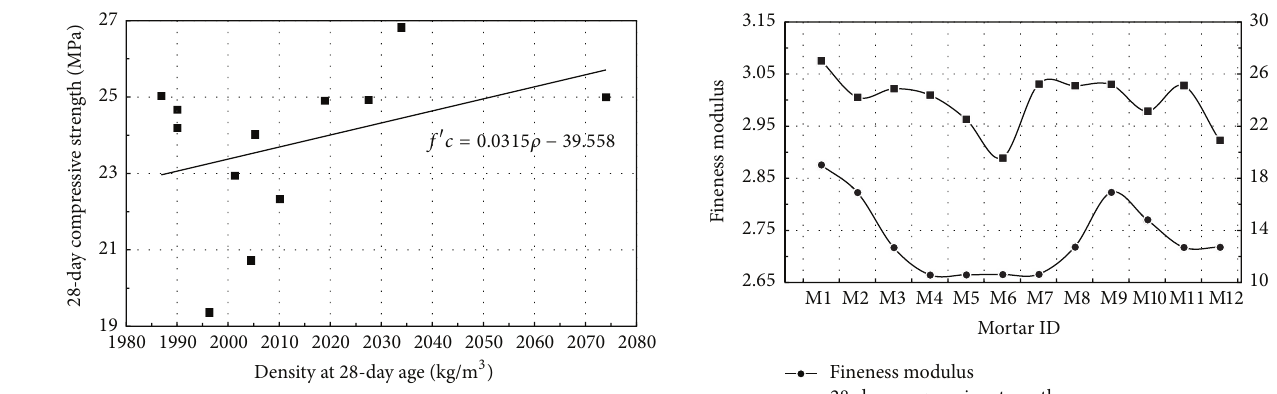
Figure 6: Relationship between density and compressive strength at 28-day age.